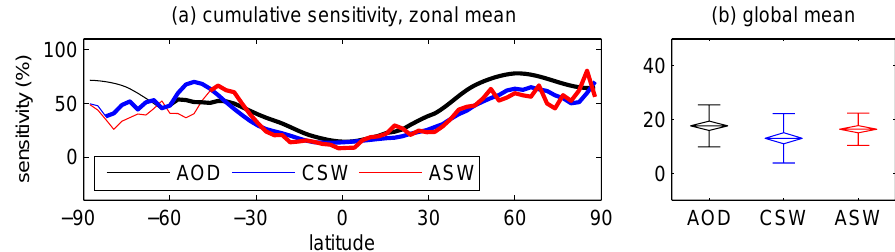
Fig. 11. As Fig. 7, for the E700 experiment. Note different